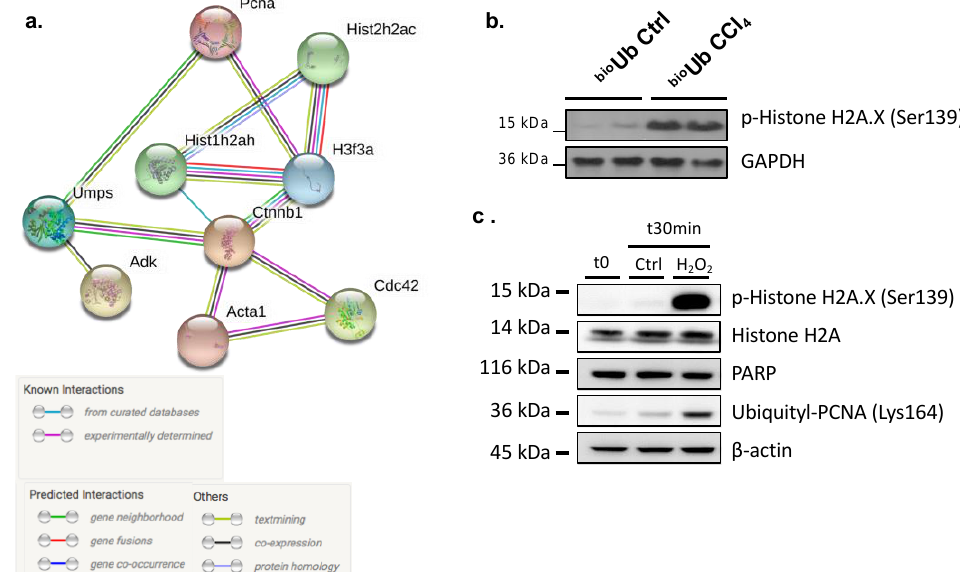
Figure 6. PCNA ubiquitination and DNA damage repair (DDR) during carbon tetrachloride (CCl 4 )-induced liver fibrosis and after hydrogen peroxide (H 2 O 2 )-induced injury to the HepG2 human cell line. ( a ) STRING analysis showing the major cluster of the predicted and previously demonstrated interactions between the identified ubiquitinated proteins on the mouse models of CCl 4 -induced liver fibrosis. ( b ) CCl 4 -induced liver fibrosis is associated with augmented DNA damage repair (DDR) as detected by the hyperphosphorylation of the Ser-139 residue of the histone variant H2AX, forming γ H2AX, a marker of activated DDR. ( c ) Stimulation of the HepG2 human cell line with H 2 O 2 at 100 μM for 30 min results in increased γ H2AX and ubiquitination of PCNA at lysine 146.